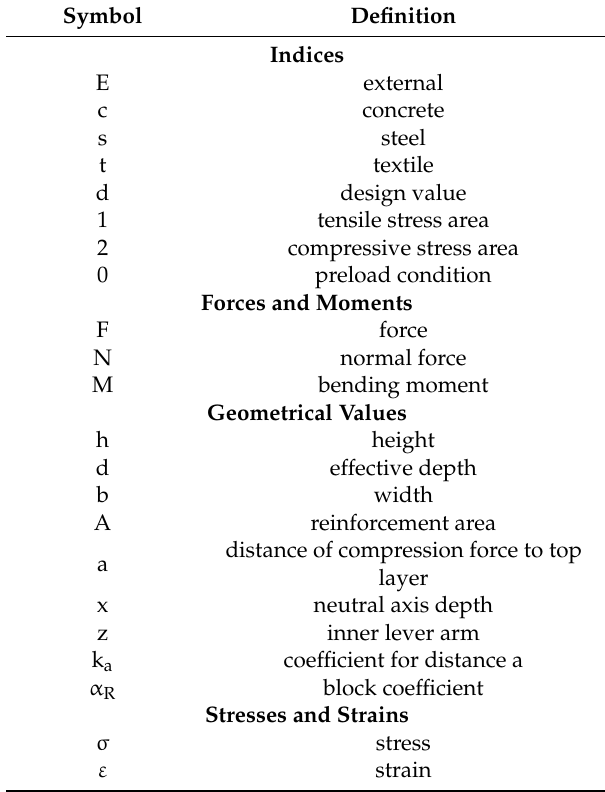
Figure 4. Principle of strengthened reinforced concrete (RC) cross section with outer and inner forces, strains and stresses. Table 1. Definition of symbols.